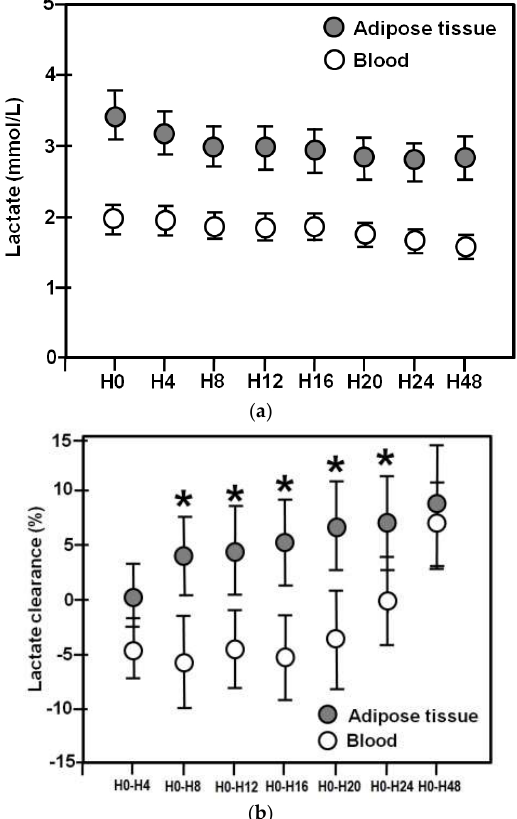
Figure 1. ( a ) Mean ( ± SE) lactate levels in adipose tissue (closed circles) and in blood (open circles) over 48 h; ( b ) Mean ( ± SE) lactate clearances in adipose tissue (closed circles) and in blood (open circles) over 48 h. Asterisks denote statistically significant differences between